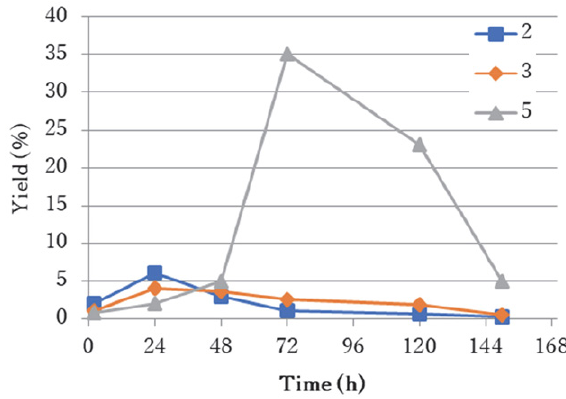
Figure 4. Evaluation of products 2 , 3 and 5 formed in the presence of synthetic alumina Al syn.